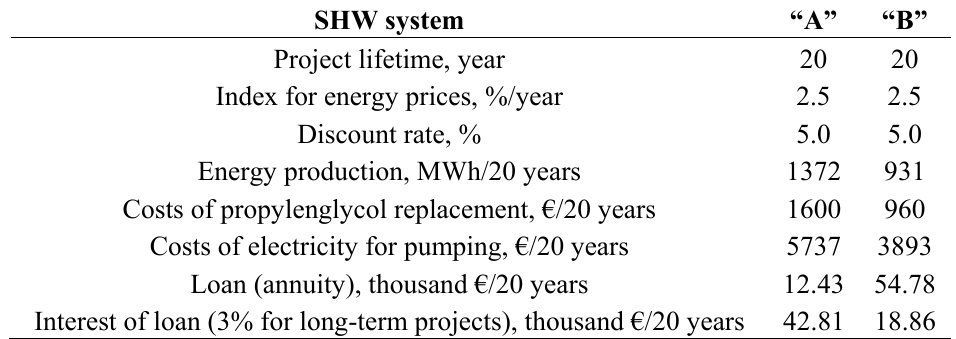
Table 3. Parameters used for financial assessment of SHW systems “A” and “B”.